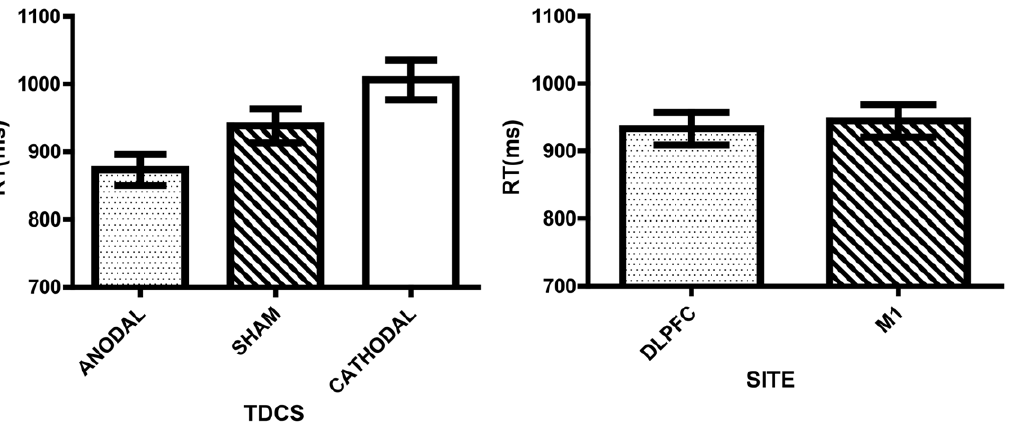
Figure 2. Performance as indexed by RT: Polarity and Site effects. Columns represent the MEAN and the bars the SEM for the RT (95% CI) in the Cognitive Task. tDCS: Represents the polarity effects in RT. Site: Represents the estimates of the RT per site of stimulation.